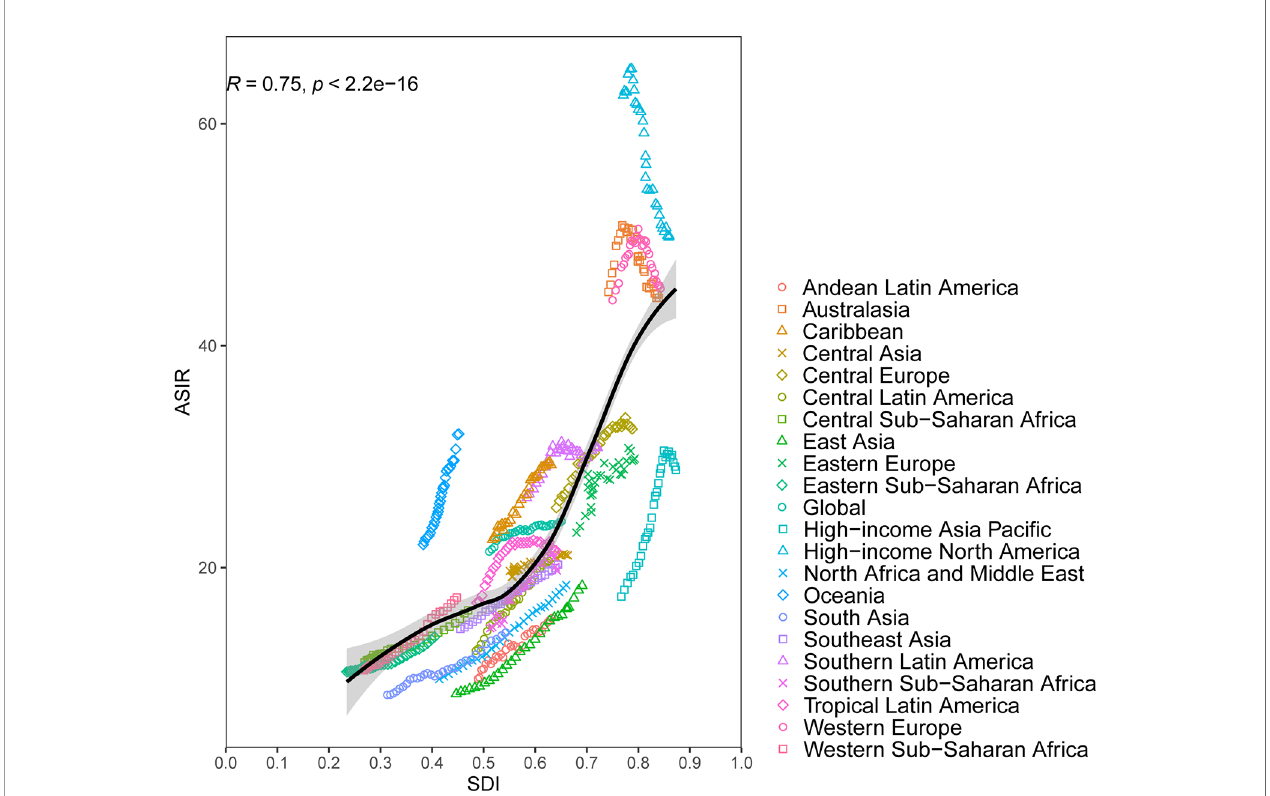
FIGURE 2 | Age-standardized incidence rates (ASIR) for breast cancer for 21 Global Burden of Disease (GBD) regions by Socio-Demographic Index (SDI), 1990 – 2019; expected values based on SDI and disease rates in all locations are shown as the black line. Thirty points are plotted for each GBD region and show observed ASIR from 1990 to 2017 for that region. The R indices and P value were derived from Pearson correlation